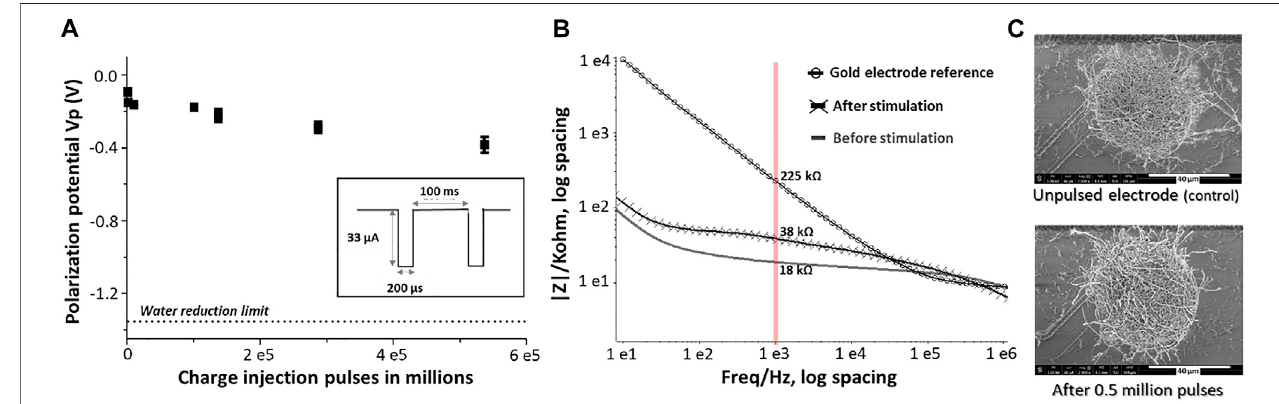
FIGURE6| LongtermstabilityassessmentofPEDOT-CNFcomposite: (A) Evolutionofpolarizationpotentialover0.5millionchargeinjectionpulsesat0.5 mC/cm 2 in aCSF. Inset- Schematic representation of the biphasic charge-balanced current waveform having an amplitude of 33 µA and 200 µs pulse duration at 10 Hz. (B) EIS monitoringofPEDOT-CNFcompositebeforeandafter0.5millionstimulationpulses. (C) SEMobservationofthecompositeafterthestimulationandcomparisonwiththe unpulsed electrode (control).